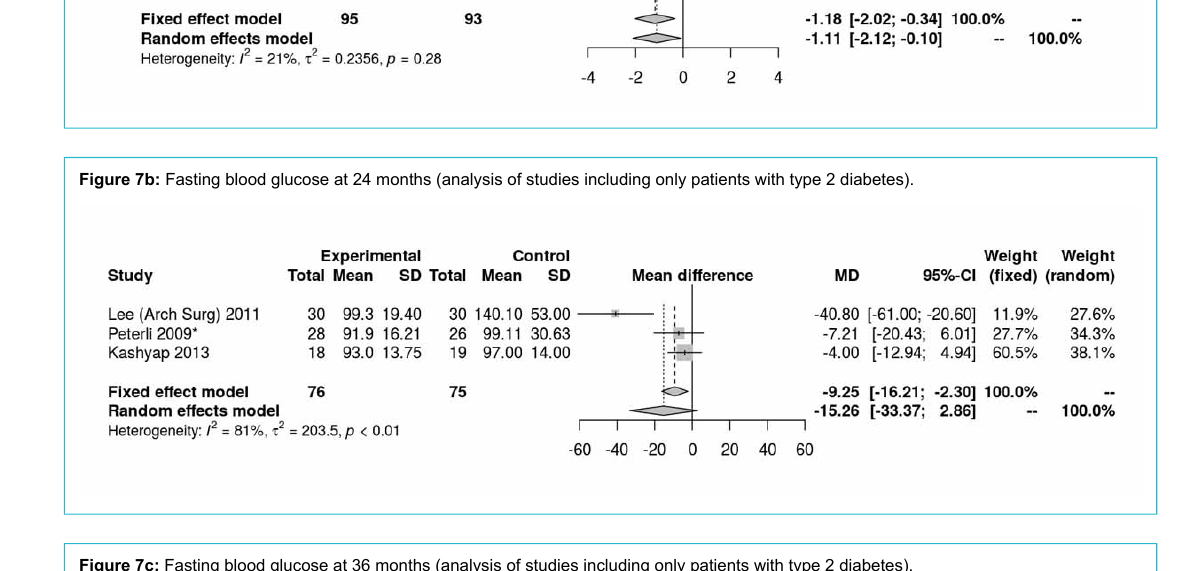
Figure 7c: Fasting blood glucose at 36 months (analysis of studies including only patients with type 2